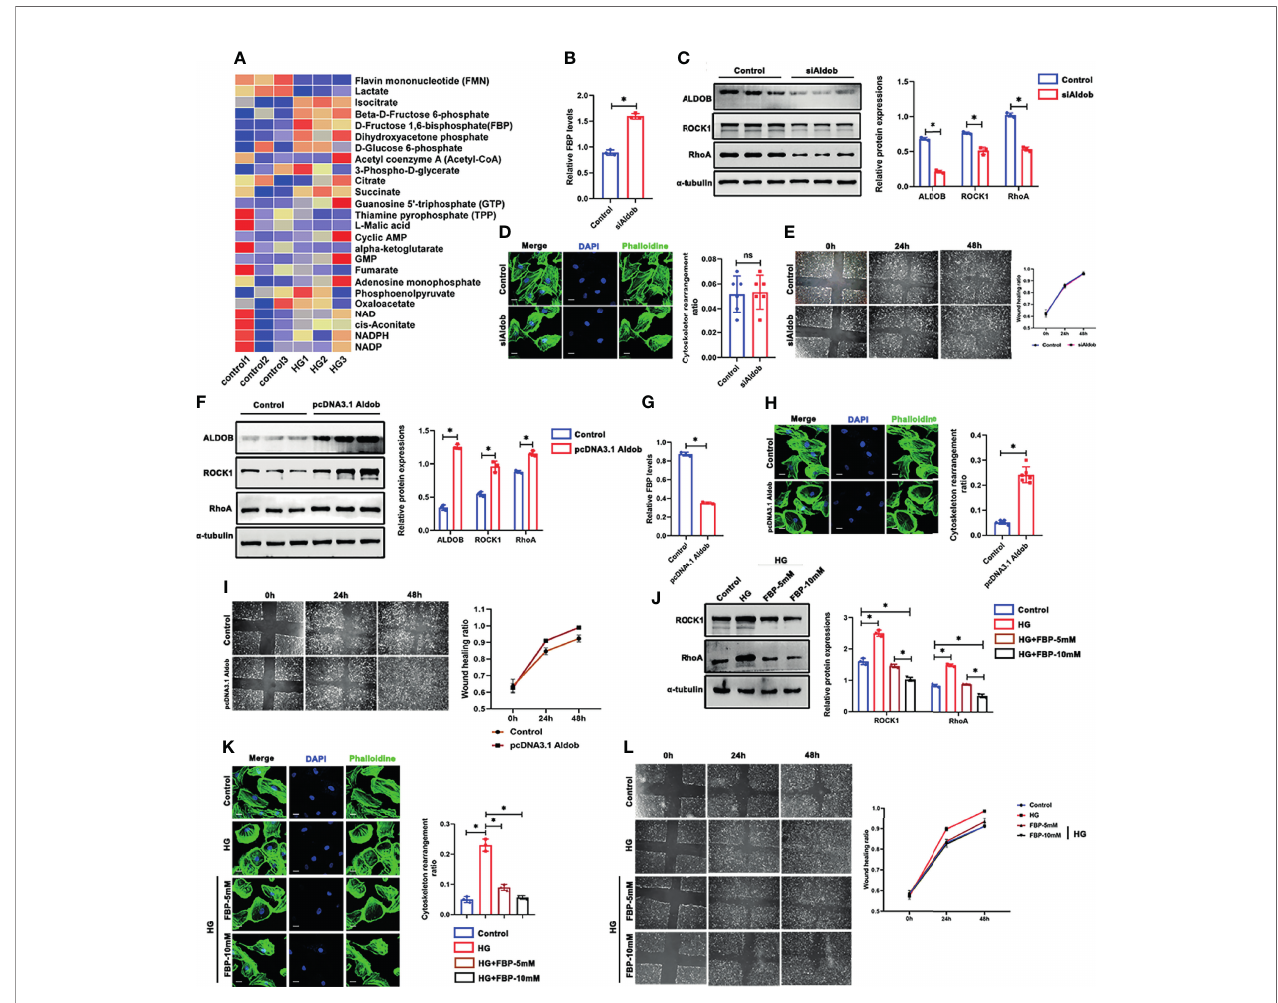
FIGURE 8 | FBP ameliorated HG-induced cytoskeletal remodeling in podocytes in vitro . (A) Targeted metabolomics was performed between control and HG group of cultured podocytes, and heat maps were generated based on levels of the metabolites related to glucose metabolism. (B) Western blots of ALDOB, ROCK1, PFKP, and RhoA after transfected with siAldob, GAPDH was set as the loading control. (C) FBP level in control and siAldob group. (D) Cytoskeletal structure of podocytes labeled with phalloidin in control and siAldob group. (E) Motility ability of podocytes were measured by wound-healing assay using an inverted microscope in control and siAldob group. (F) Western blotting analyses the expression of ALDOB, ROCK1, PFKP, and RhoA in podocytes after transfected with pcDNA3.1-Aldob. GAPDH was set as loading control. (G) FBP level in control and pcDNA3.1-Aldob group. (H) Cytoskeleton structure of podocytes labeled with phalloidin in control and pcDNA3.1-Aldob group. (I) Motility ability of podocytes were measured by wound-healing assay using an inverted microscope in control and pcDNA3.1-Aldob group. (J) Western blotting analyses the expression of ALDOB, ROCK1, PFKP, and RhoA in podocytes after FBP treatment. GAPDH was set as loading control. (K) Cytoskeleton structure of podocytes labeled with phalloidin in each group. (L) Motility ability of podocytes were measured by wound-healing assay using an inverted microscope in each group. For all fi gures, n=3 independent experiments/group. * P < 0.05, ns, No signi fi cance. Scale bars: 10 µm. HG, high glucose; FBP, fructose-1,6-bisphosphate; ROCK1, Rho- associated, coiled-coil containing protein kinase 1; PFKP, Phosphofructokinase 1 platelet type; RhoA,